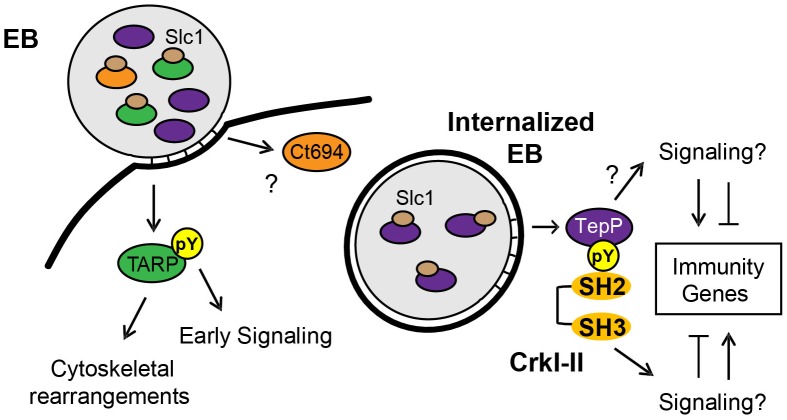
Model of the regulation and function of early effectors in signaling events occurring during the establishment of a nascent Chlamydia inclusion.The EB form of C. trachomatis is pre-loaded with multiple T3S effectors and chaperones. The majority of TARP and Ct694, two known early effectors, are pre-complexed with their cognate chaperone, Slc1, whereas only a small portion of TepP is in complex with Slc1. Upon Chlamydia attachment, TARP and Ct694 are translocated into host cell cytoplasm, freeing Slc1 to associate with TepP and enhance its secretion. TepP is translocated across membranes and phosphorylated by host tyrosine kinases. Phospho-TepP then recruits the host scaffolding protein, Crk, through interacting with the SH2 domain of Crk. The SH3 domain of Crk then recruits other host proteins to the nascent inclusion to initiate signaling cascades within the infected cell. TepP may also recruit additional proteins to initiate signaling responses independent of Crk.